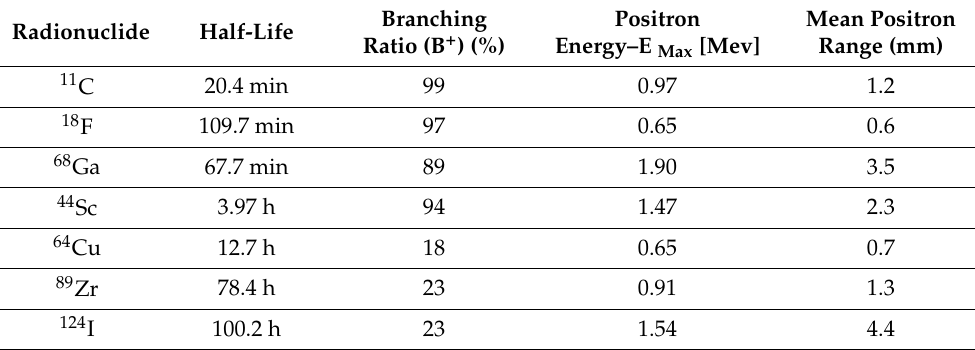
Table 2. Summary of PET radionuclides characteristics used in immunoPET. Data extracted from [57,58]. Radionuclide Half-Life